Question: Describe this figure in one sentence.
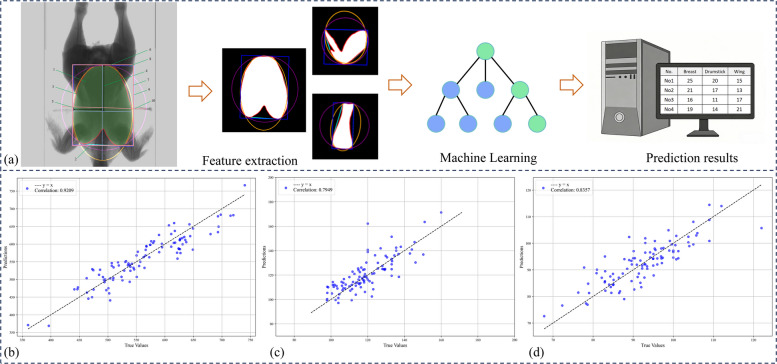
Answer: Workflow of morphological feature-based weight prediction and model fitting performance for key carcass-related traits. a Schematic illustration of the weight prediction pipeline, including feature extraction from segmented carcass components, machine learning-based regression modeling, and generation of predicted trait values. b Scatter plot of predicted versus measured breast weight. c Scatter plot of predicted versus measured drumstick weight. d Scatter plot of predicted versus measured wing weight. The dashed line represents the line of identity ( y = x )